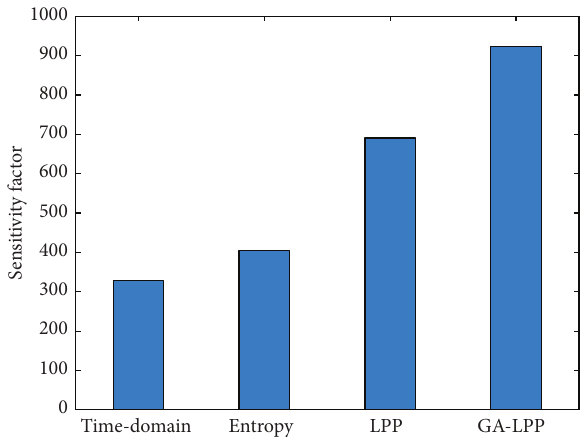
Figure 11: Clustering effects of different combinations of features.